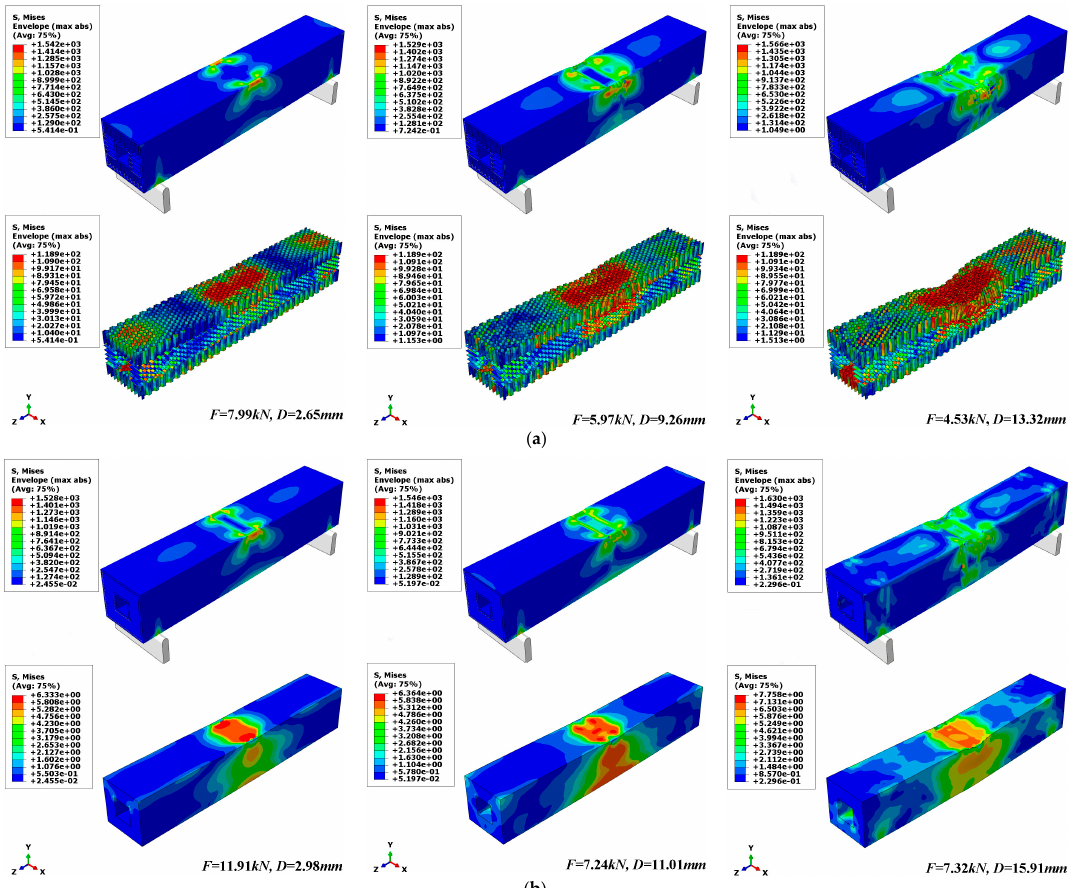
Figure 16. Failure modes of composite sandwich laminated box beam. ( a ) Aluminum honeycomb core; ( b ) Aluminum foam core.